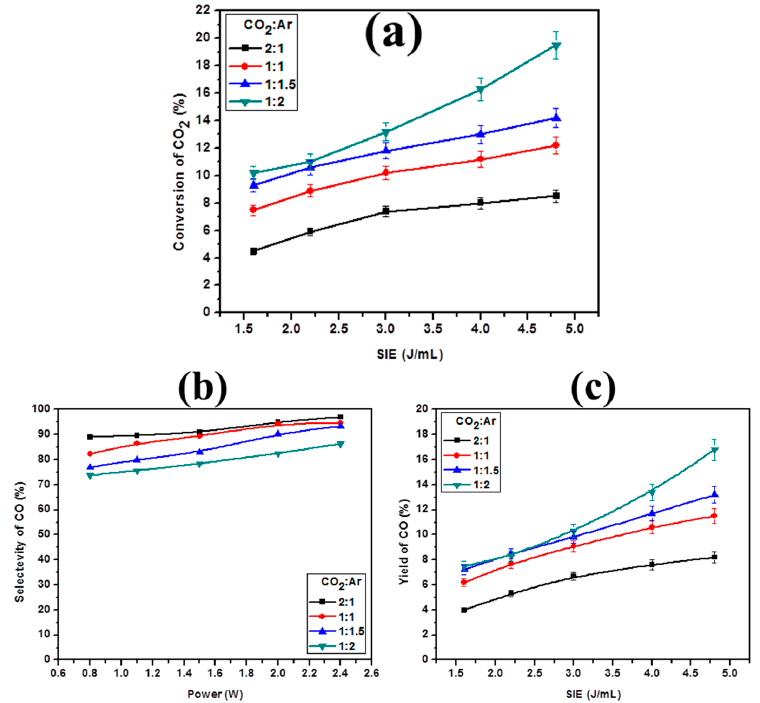
Figure 5. ( a ) CO 2 conversion with the change of SIE; ( b ) Selectivity of CO with respect to power; ( c ) Yield of CO with the variation of SIE. (Flow rate 30 mL/min, Glass beads packed, Plasma frequency 50 Hz).